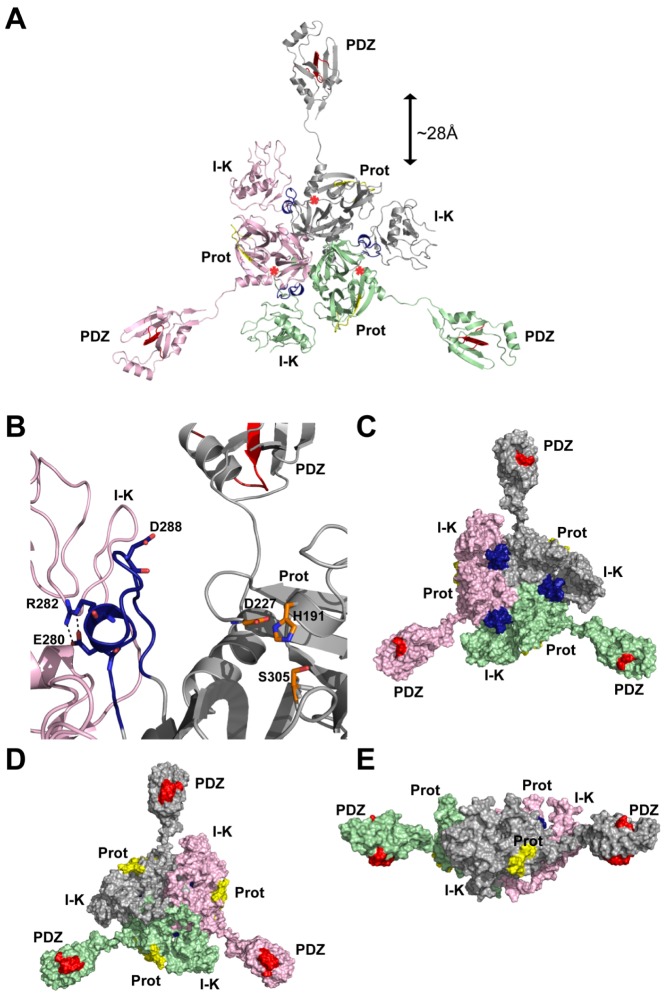
The trimeric HtrA3 homology model and location of the epitopes for mAbs 10H10, 2C4 and 3E6.(A) Cartoon representation of the trimeric HtrA3 (HtrA3-L) homology model, with each of the three HtrA3 monomers colored differently (grey, light green and light pink). Individual domains within each monomer are labeled: I-K; N-terminal combined IGFB-Kazal domains; Prot; central protease domain, and PDZ; the PDZ domain. Red asterix indicates the location of the catalytic site in each monomer. Epitope for the inhibitory mAb 10H10, residues 278–292 in the protease domain, is colored dark blue and corresponds to the putative HtrA3 sensor loop L3 [28]. Epitopes for mAbs 2C4 (residues 230–239) in each protease domain and 9C9 (residues 403–417) located in the PDZ domain are colored yellow and red, respectively. View directly above the protease catalytic sites. (B) Close up view of the 10H10 inhibitory epitope (dark blue) and modeled protease catalytic triad (orange sticks) for one HtrA3 monomer (grey cartoon). Catalytic triad residues His-191, Asp-227 and Ser-305 are displayed as orange sticks; Glu-280, Arg-282 and Asp-288 of the putative L3 sensor loop are displayed as dark blue sticks. Salt bridge/hydrogen bond interactions between Glu-280 and Arg-282 are shown as dashed black lines. The adjacent HtrA3 monomer is shown as a light pink cartoon. (C) Same view as in panel (A), protein is depicted as a molecular surface. (D) View of the non-catalytic face of HtrA3, i.e. a rotation of +180o about the Y-axis from the view shown in panels (A) and (C). (E) Side view of the grey monomer [−90o rotation about the X-axis, followed by a +120o rotation about the Y-axis from the view shown in panel (A)]. One letter amino acid codes have been used for labels.